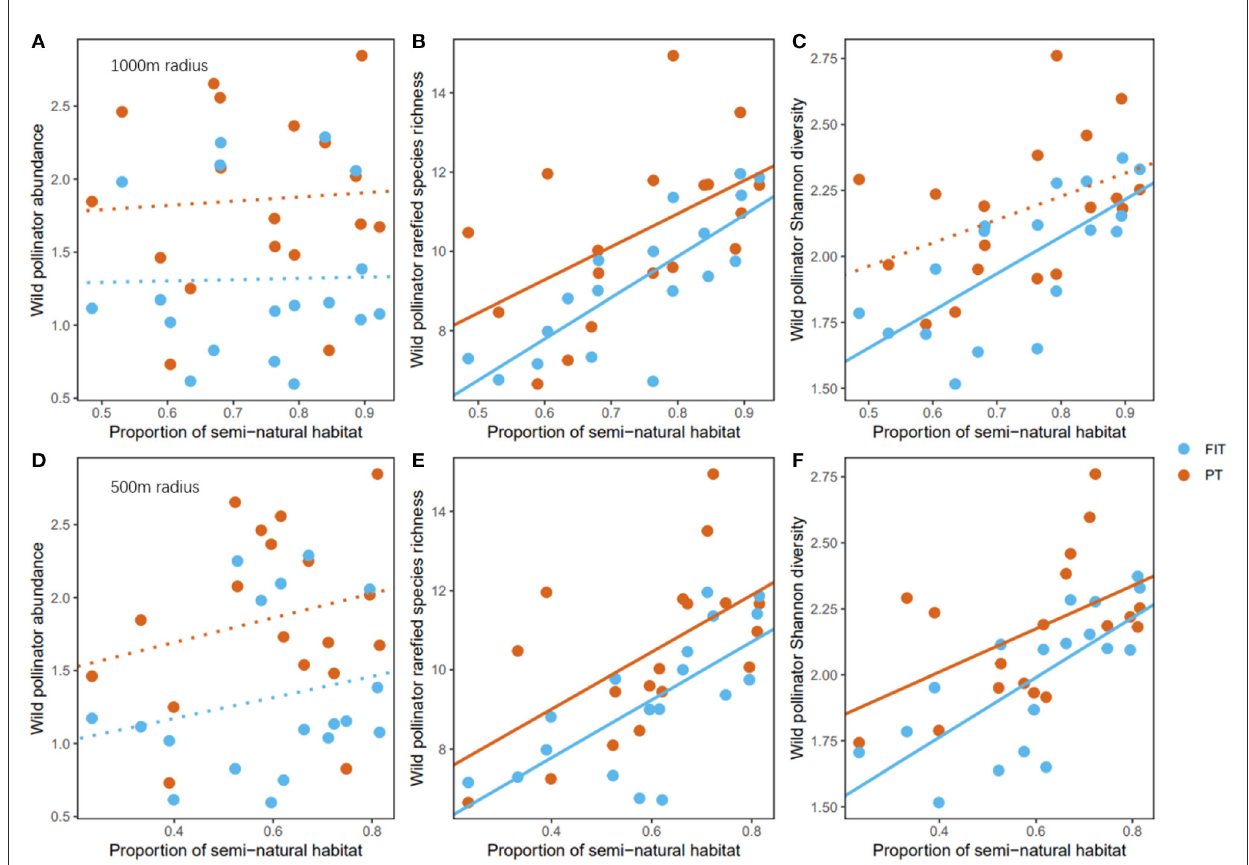
FIGURE6 The impact of sampling methods (FIT and PT) and the proportion of semi-natural habitat in on (A, D) wild pollinator abundance (per sampling day), (B, E) rarefied species richness and (C, F) Shannon diversity. (A–C) were in 1000m radius and (D–F) were in 500m radius scale. Solid lines occur where the impact of semi-natural habitat was significant ( p < 0.05).